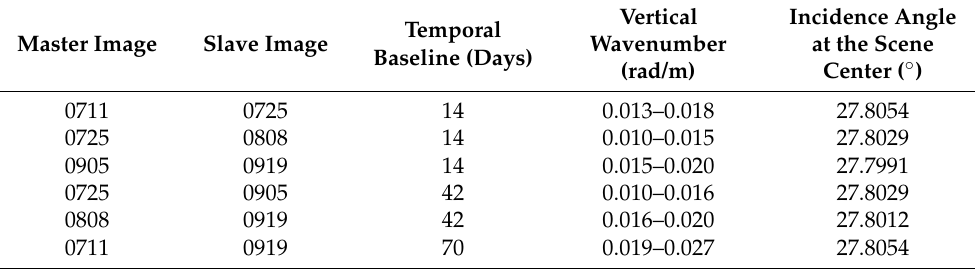
Table 3. Information on the ALOS-2 PALSAR data.